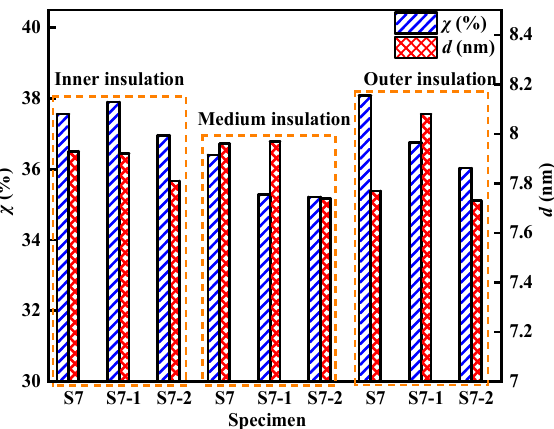
Figure 4. The change in χ (%) and d before and after the combined electrothermal aging test. The stacking form of the molecular chains determines whether the aggregation struc-